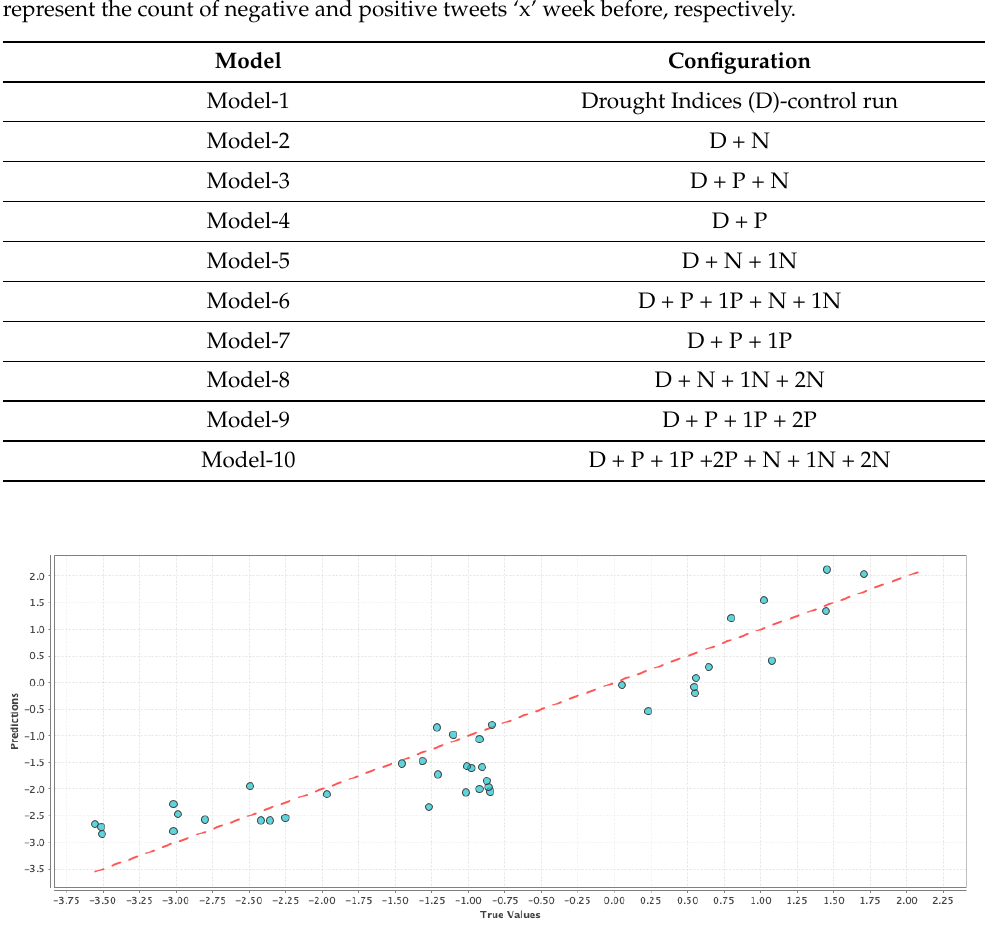
Figure 1. Result on the Test Set For Generalized Linear Model. The x-axis represents the true or the actual PDSI values and the y-axis represents the predicted PDSI values. Each small blue circle in the figures is represented by the tuple ( PDSI actual , PDSI pred ). The red dashed line is the reference line to test the model